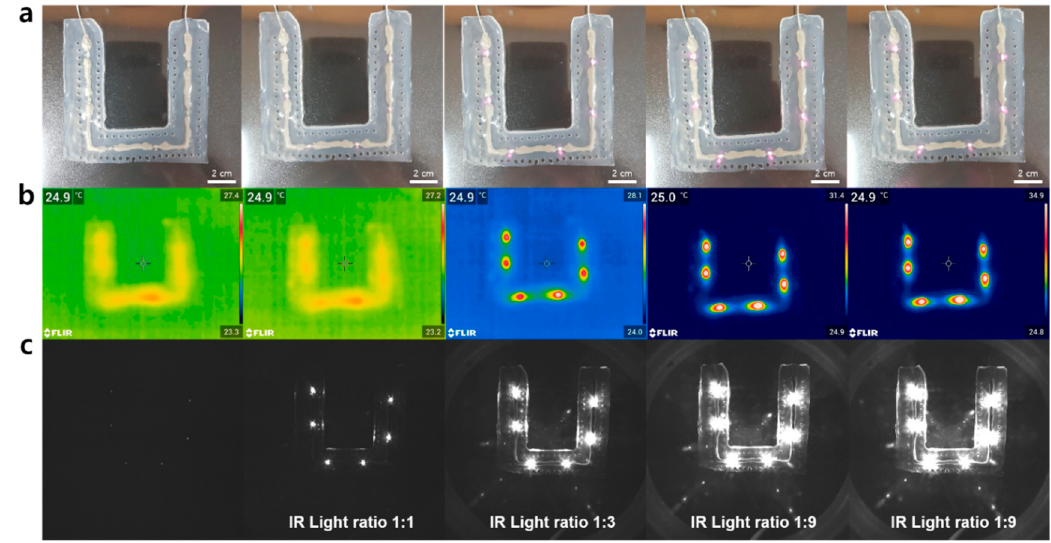
Figure 5. Light emission and near IR recognition test of the patch. ( a ) Images of the fiducial marker patch. ( b ) Thermal imaging camera images of the patch. ( c ) Near-IR camera images of the patch.